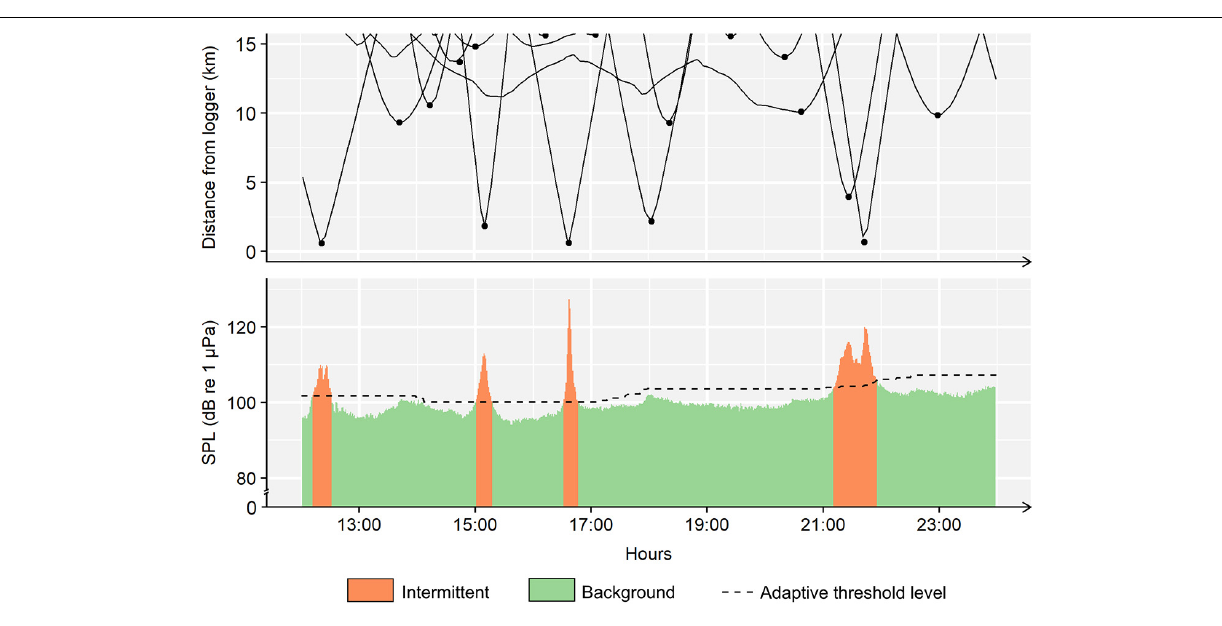
speed was ruled out as an independent variable at logger 22.